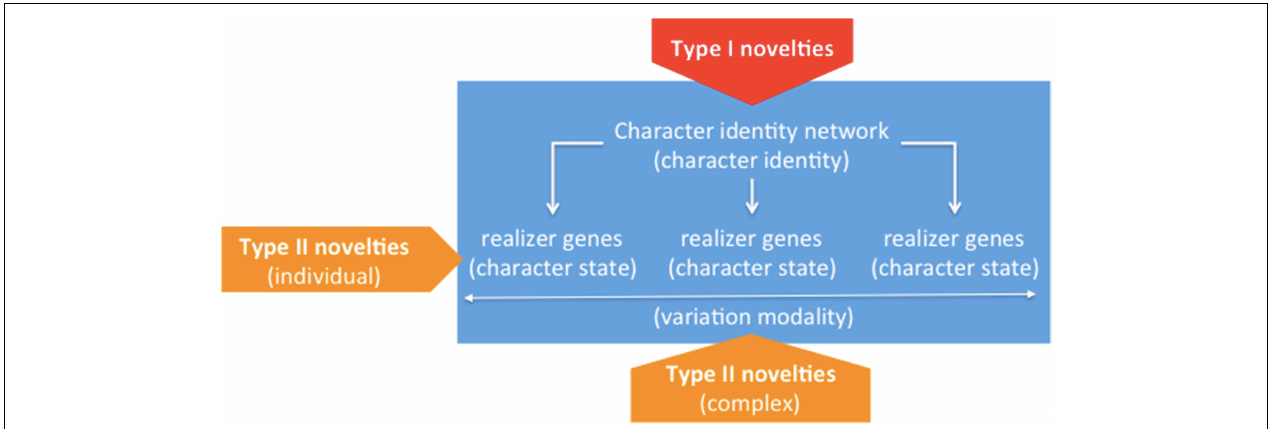
FIGURE 2 | Constitutive dimensions of characters (“identity” vs. “states/modalities”) and underlying generative mechanisms (“ChINs” vs. “realizers”). Within pentagons, novelty types associated to the corresponding loci (“Type I” vs. “Type II”).